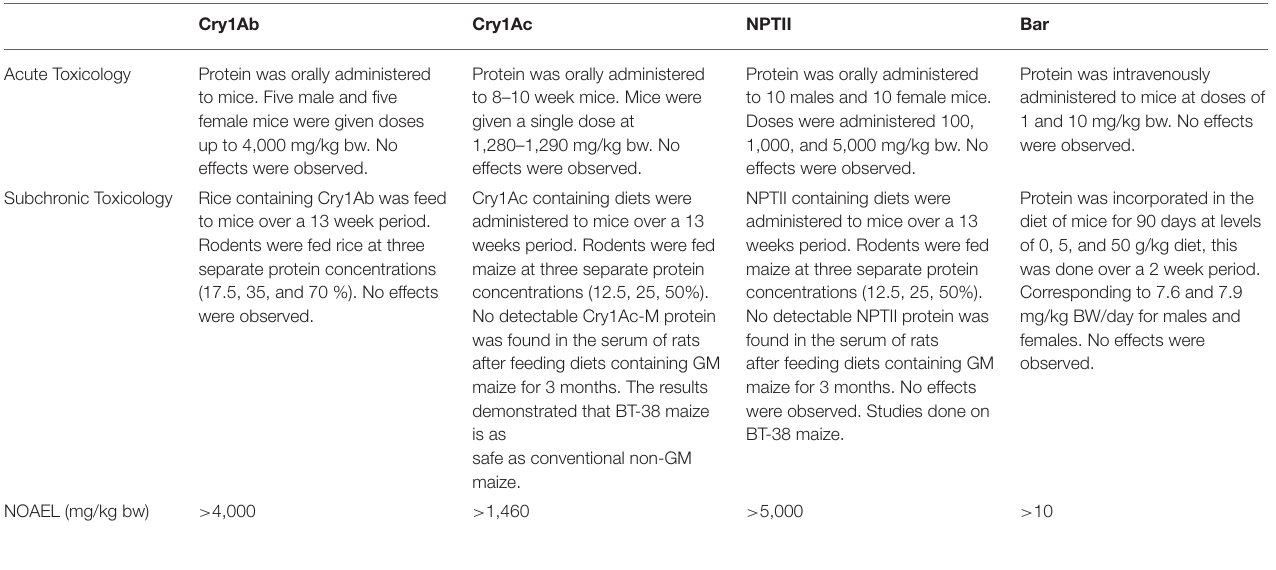
TABLE 1 | Toxicology study results for Cry1Ab, Cry1Ac, NPTII, and bar proteins. Cry1Ab Acute